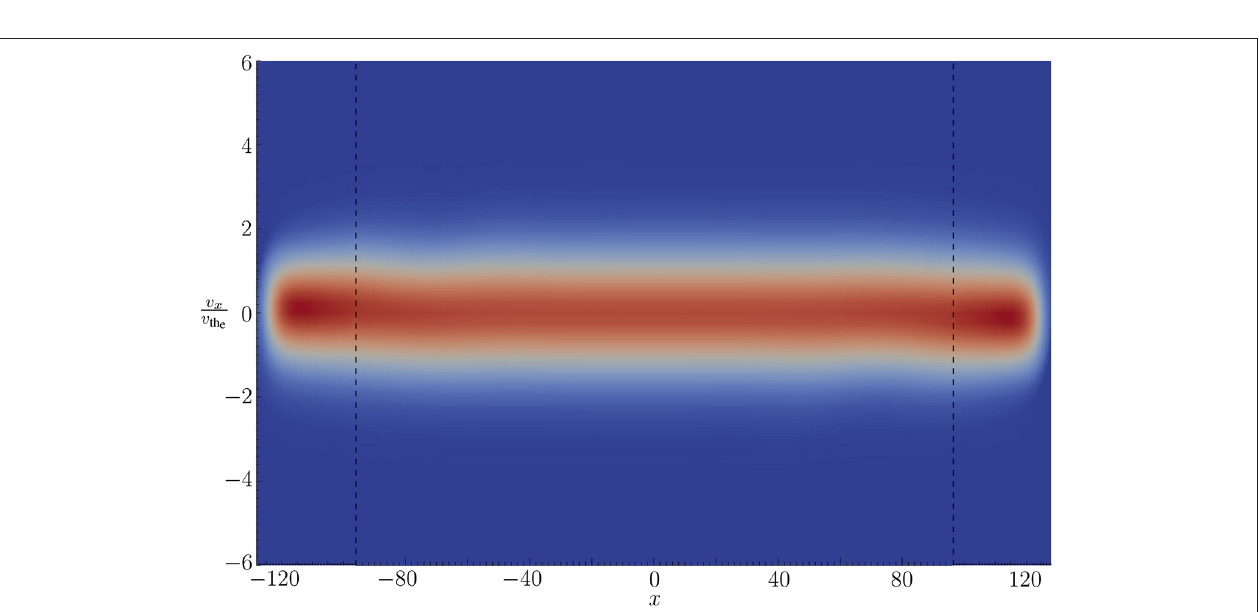
FIGURE 12 | Contours of the ion distribution function at t x [ 128, 96] and x [96,128] are modeled with the continuum kinetic two-species plasma model, and the middle subdomain x ∈ − − ∈ 5 N -moment two-fluid plasma model.